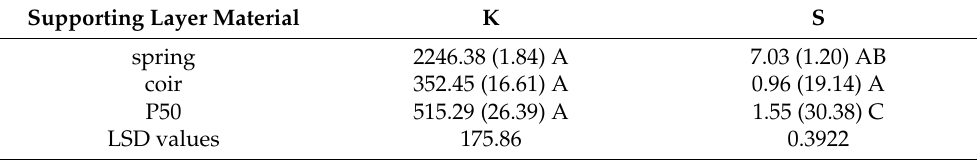
Table 7. The mean hardnesses of the mattresses evaluated in this study (supporting